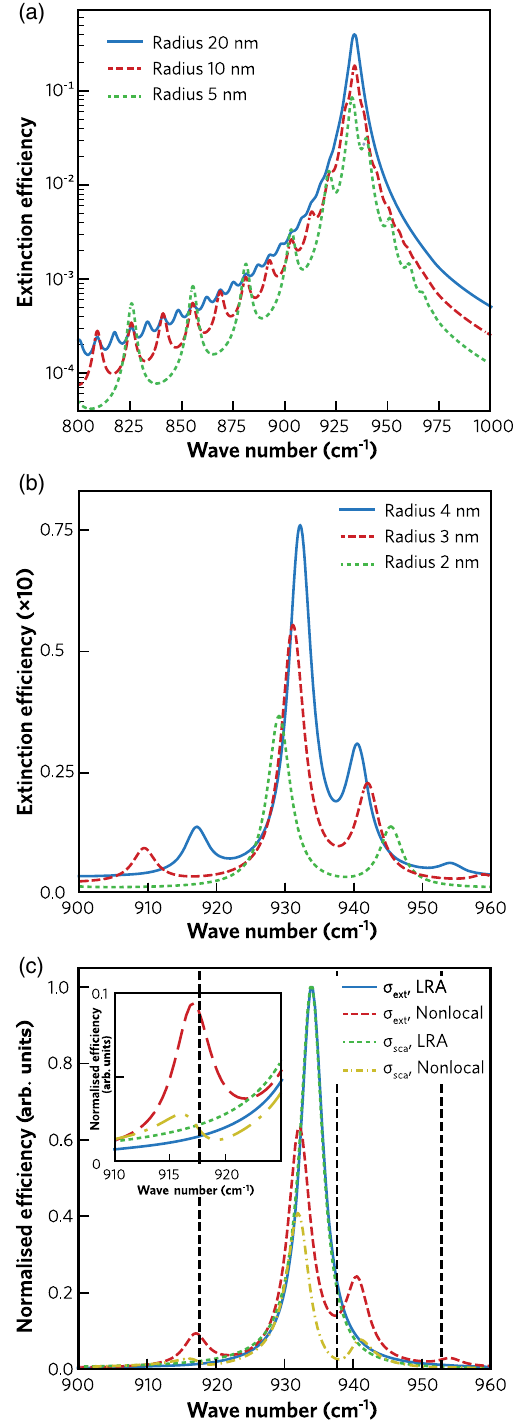
FIG. 2. Panels (a) and (b) show a comparison of nonlocal extinction efficiencies for 3 C -SiC spheres of different radii. (c) De- tailed comparison of the extinction ( σ ) and scattering ( σ ) cross ext sca sections for a 4-nm-radius sphere in the local and nonlocal cases. Bothcurveshavebeennormalizedtounitysotheymaybepresented on the same vertical scale. The inset is an enlargement of the resonance near 905 cm − 1 . The vertical dashed lines indicate the frequencies of the bare, discrete longitudinal